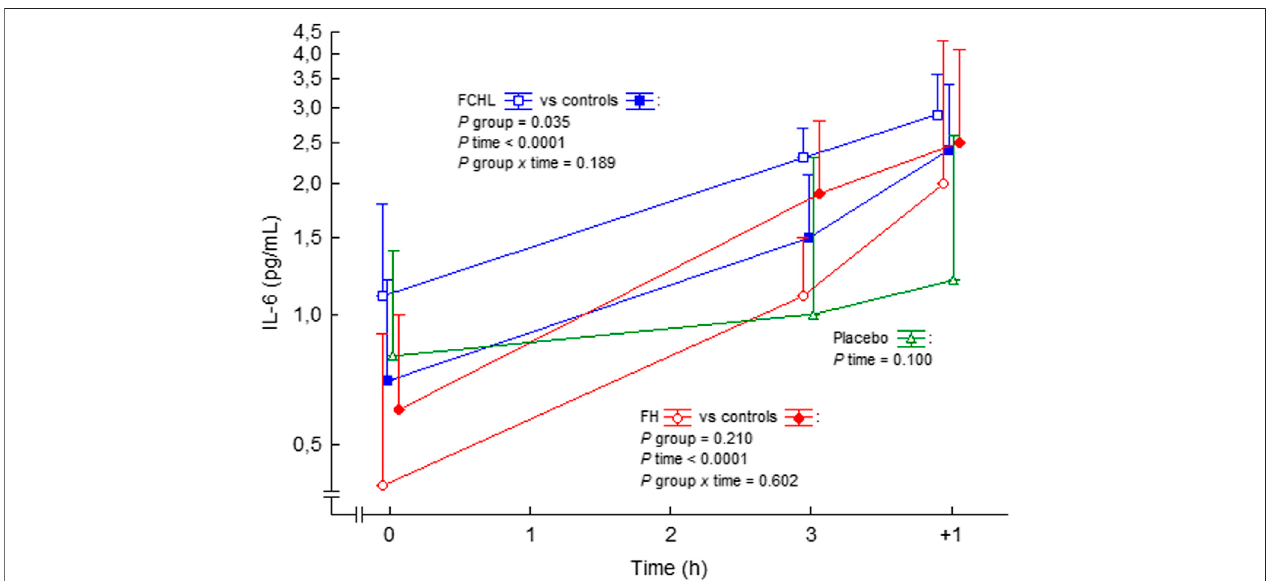
FIGURE4| IL-6inplasmabefore,duringandafterintravenous3 hsteadystateangiotensinIIinfusioninman.Dataarepresentedasmedianvaluesandinterquartile ranges. Statistical evaluation was made by repeated measures ANOVA. PAI-1, plasminogen activator inhibitor-1; FCHL, familial combined hyperlipidemia, and FH, familialhypercholesterolemia.FCHL,bluelineandun fi lledsquares( n (cid:1) 16);FCHL-control,bluelineand fi lledsquares( n (cid:1) 16);FH,redlineandun fi lledcircles( n (cid:1) 16),and FH-control,redlineand fi lledcircles( n (cid:1) 16).Theeffectofphysiologicalsalineinfusioninplaceboexperiments,greenlineandun fi lledtriangles( n (cid:1) 8),isalsoshown. Data from (Ekholm et al., 2009; Ekholm et al.,